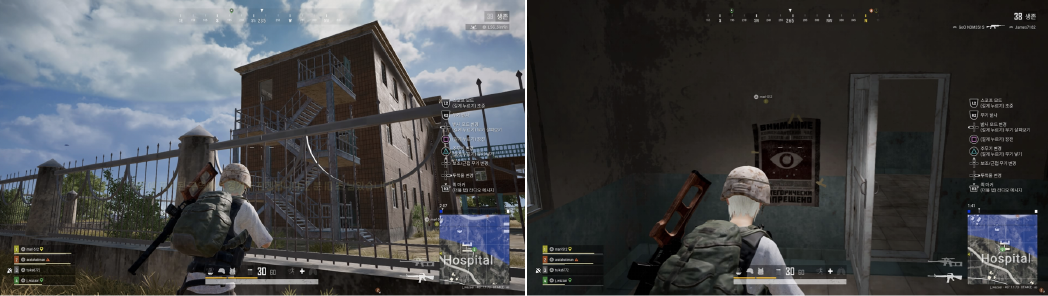
Figure 7. The figure on the left is a screenshot of PlayerUnknown’s Battlegrounds (PUBG) gameplay within the Hospital’s vicinity. The figure on the right is a screenshot of PUBG gameplay within the building in the Hospital